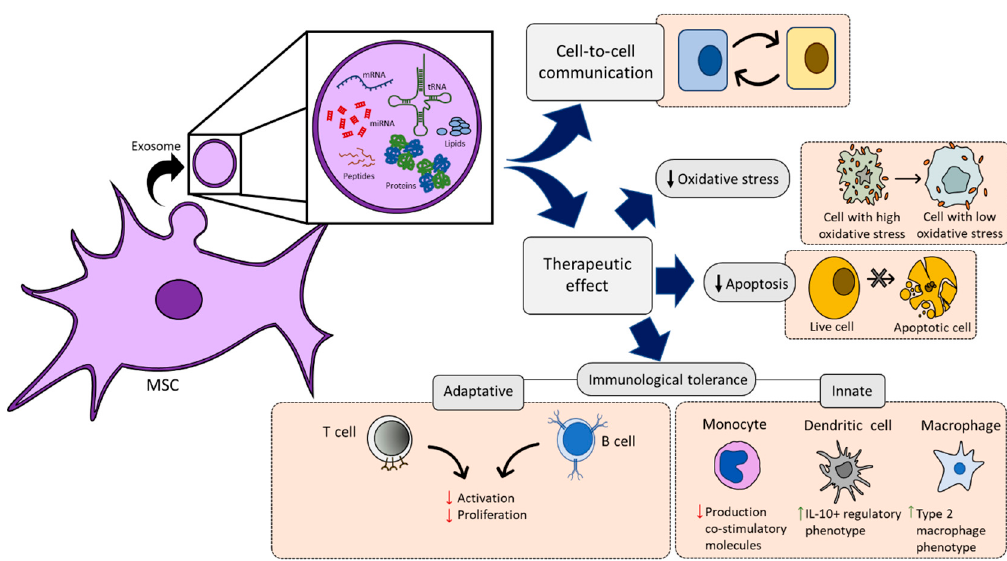
Figure 5. Mesenchymal stromal cell-secreted exosomes perform a role in cell-to-cell communication, as well as triggering therapeutic e ff ects, by a reduction of oxidative stress, increasing cell live expectancy, and exhibiting an immunological tolerance through the reduction of activation and proliferation of adaptative immune cells and the di ff erentiation of innate cells towards regulatory